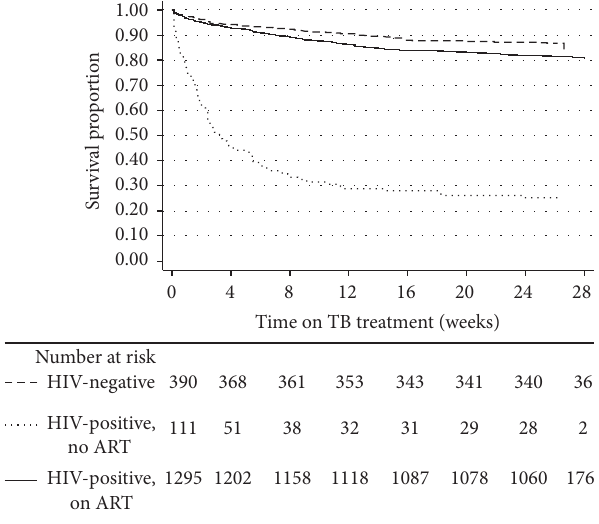
Figure 3: Kaplan-Meier survival estimates stratified by HIV status and ART initiation. TB = tuberculosis; HIV = human immunode- ficiency virus; ART = antiretroviral therapy. Note: the numbers of HIV-negative patients and those HIV-positive on ART and not on ART differ from those presented in Table 1 because some patients were excluded from survival analysis because of missing outcome status